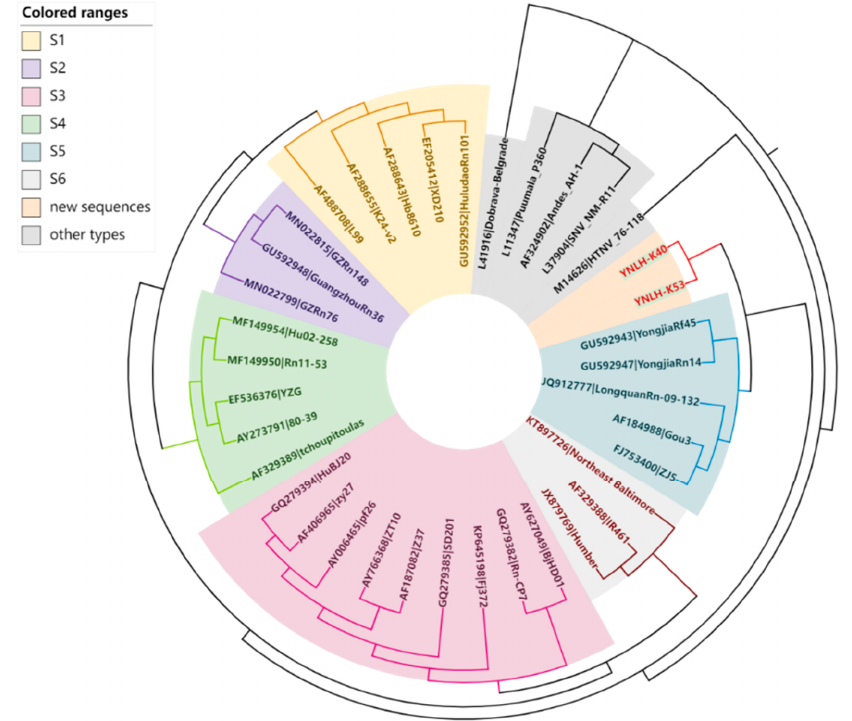
Figure 2. Phylogenetic tree constructed using nucleotide sequences of the Seoul virus partial S-segment gained from Yunnan Province, China. S1 to S6 are the six subtypes of SEOV, respectively, and the gray part covers the five other types of HV of HTNV, PUUV, SUV, ANDV and DOBV.